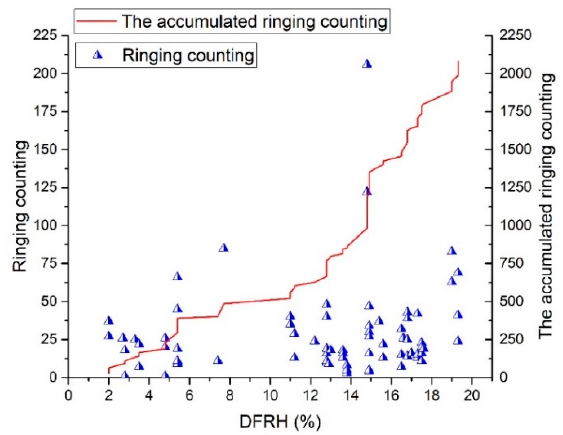
Figure 13. Relationship between DFRH and the accumulated ringing counting, ringing counting.